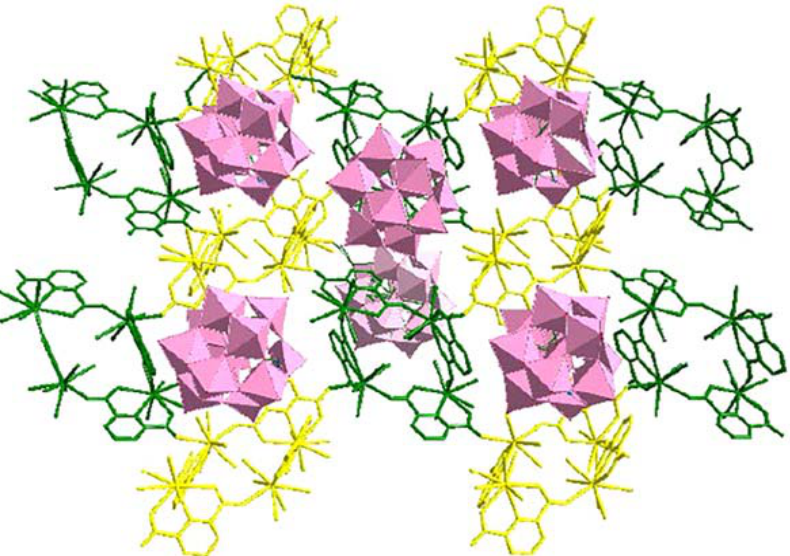
Fig. 7. Connecting four nuclear cycles to each other and forming a larger ring of eight nuclear and accommodate POMs to metal-organic framework structure and formation of hybrid inorganic- organic materials based on POMs. Adapted from Ref [17].